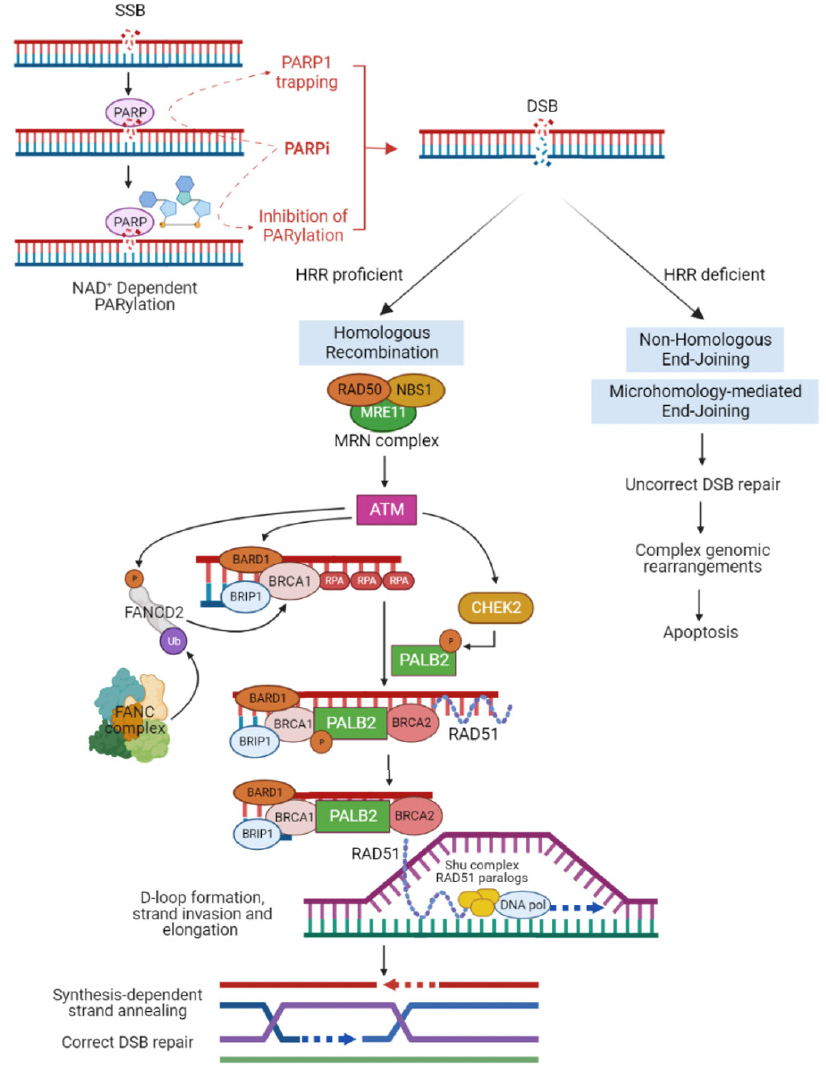
Figure 1. Overview of DNA double-strand break repair mechanisms and PARP inhibitor function. PARP inhibitors (PARPi) act mainly in two ways, both by inhibiting the catalytic activity of PARP1